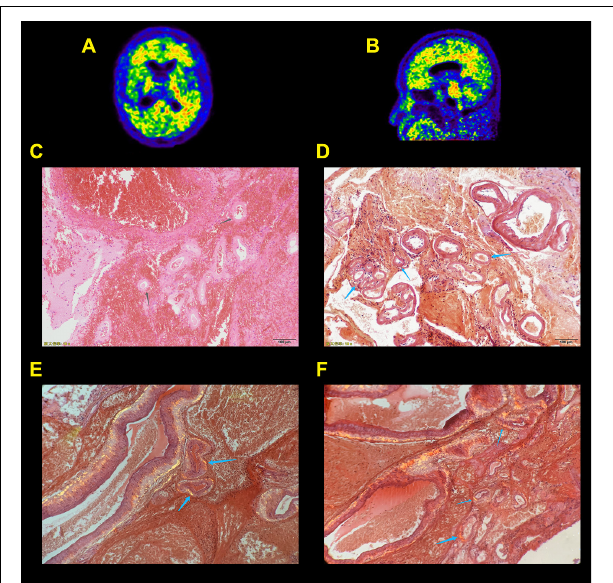
FIGURE 1 | Probable cerebral amyloid angiopathy patient (CAA) with supportive pathology. Axial (A) and sagittal (B) Pittsburgh compound B (PIB) positron emission tomography (PET) scans show increased global neocortical PIB deposition with an occipital, temporal predominance. Photomicrographs show right temporal and parietal intracerebral hemorrhage in cerebral tissue sections stained with a hematoxylin and eosin stain (C) . A Congo red stain (D–F) demonstrates irregularly dilated blood vessels with fresh hemorrhage (gray arrows), and Congo red–positive blood vessel walls exhibit green birefringence with polarized light (blue arrows).